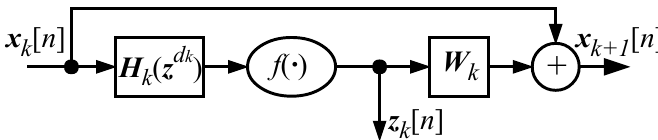
Figure 2. Block diagram of a single convolutional layer.